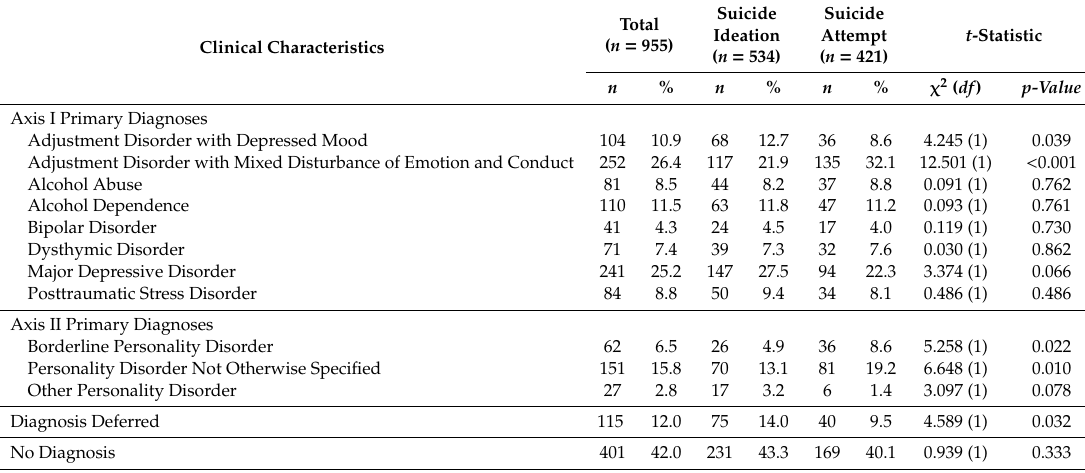
Table 2. Clinical charecteristics across military psychiatric inpatients hospitalzied for suicide attempt versus suicide ideation ( n =